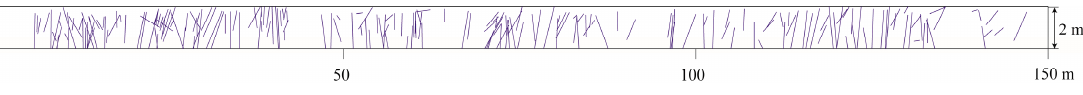
Figure 2. The illustration of the 2D joint traces.